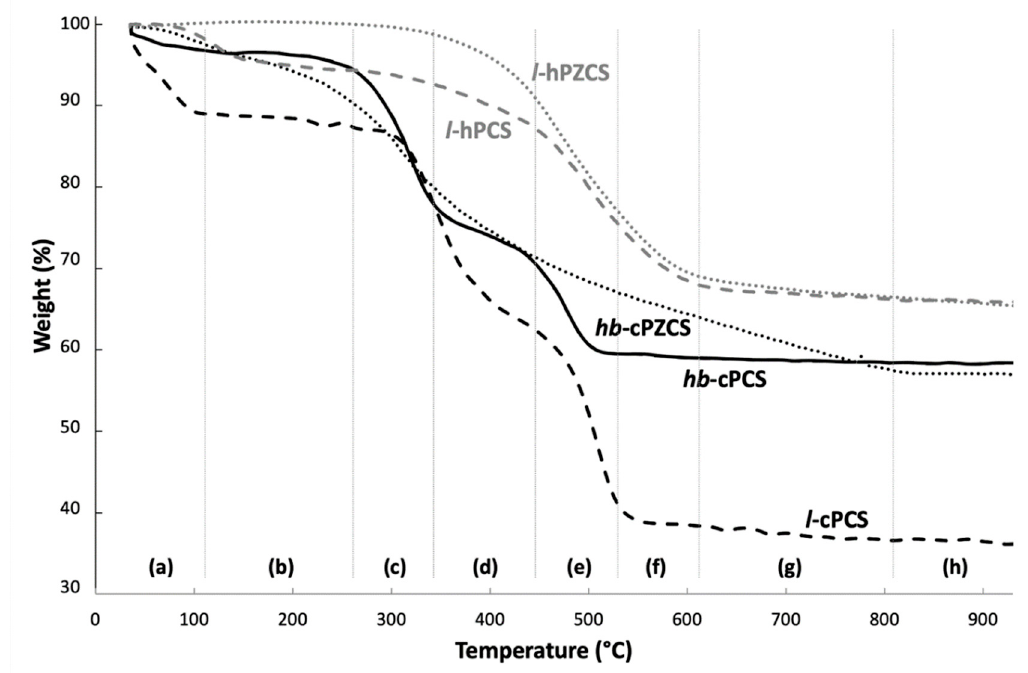
Figure 4. TG profiles from thermal analysis of the different preceramic precursor PCS ( a – h : temperature domains). After pyrolysis at 1400 ◦ C of the polymers l -cPCS and hb -cPCS , the predominant phases present are β -SiC and graphitic carbon. The presence of Cu x Si 1 − x -type impurities